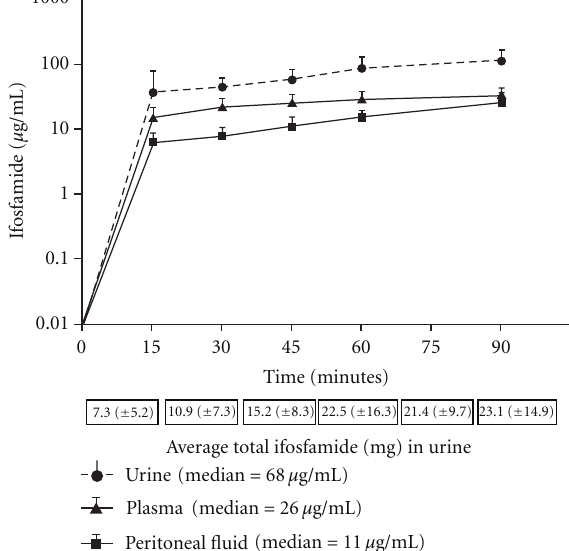
Figure 1: Plasma, peritoneal fluid, and urine concentrations of ifosfamide during a 90-minute continuous infusion. The total quantity of ifosfamide in mg excreted in the urine is presented at the bottom. The median concentration of plasma, peritoneal fluid and urine ifosfamide is shown